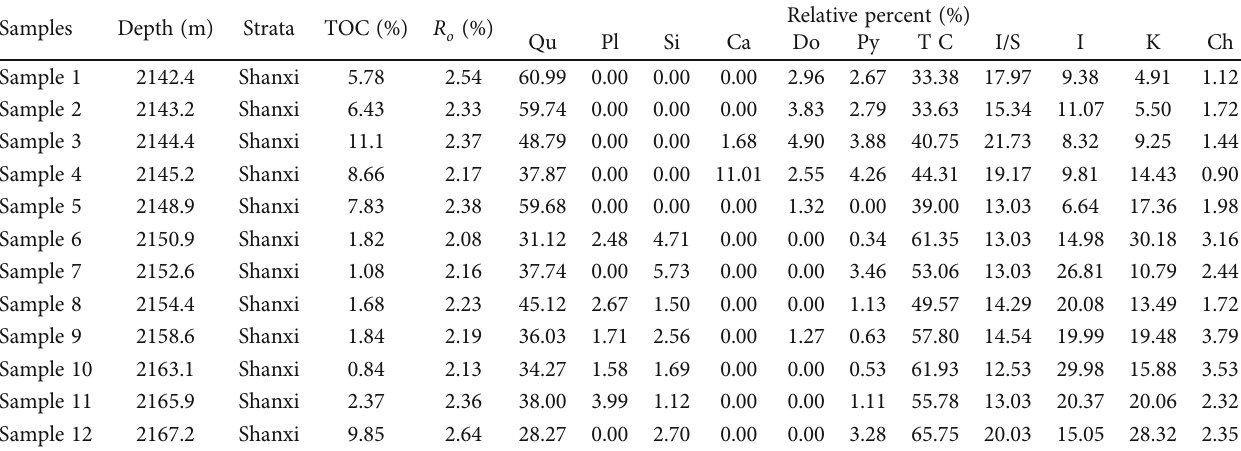
Figure 1: (a) Location of the study area. (b) Integrated strata of the Shanxi Formation in the Ordos Basin. Table 1: Geochemical characteristics and mineralogical compositions of shale